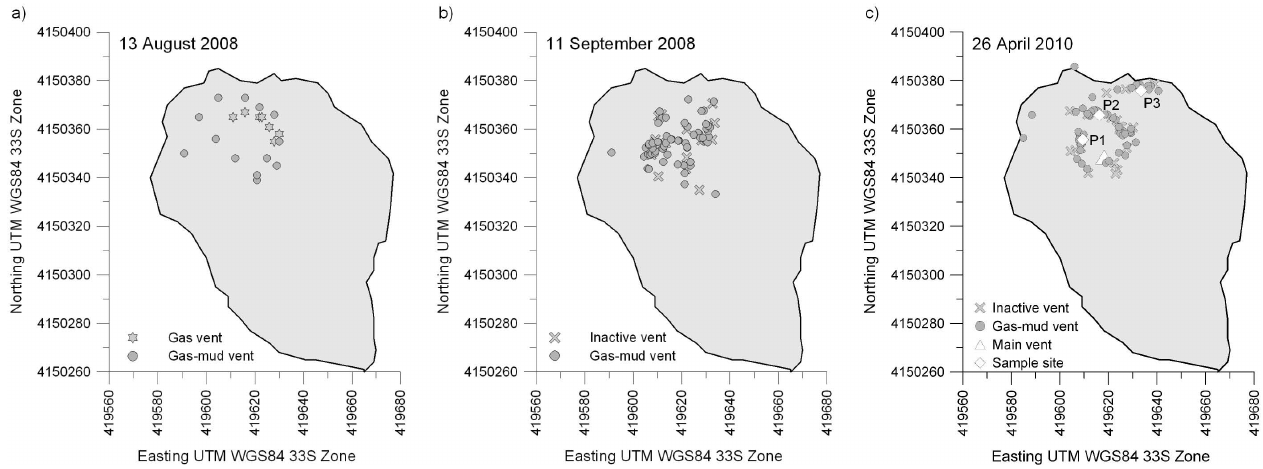
Fig. 4. Perimeter of mud volcano deposit (grey area) of the 11 August 2008 eruption with location of the emitting vents in three different periods: (a) 13 August 2008 (b) 11 September 2008; (c) 26 April 2010.